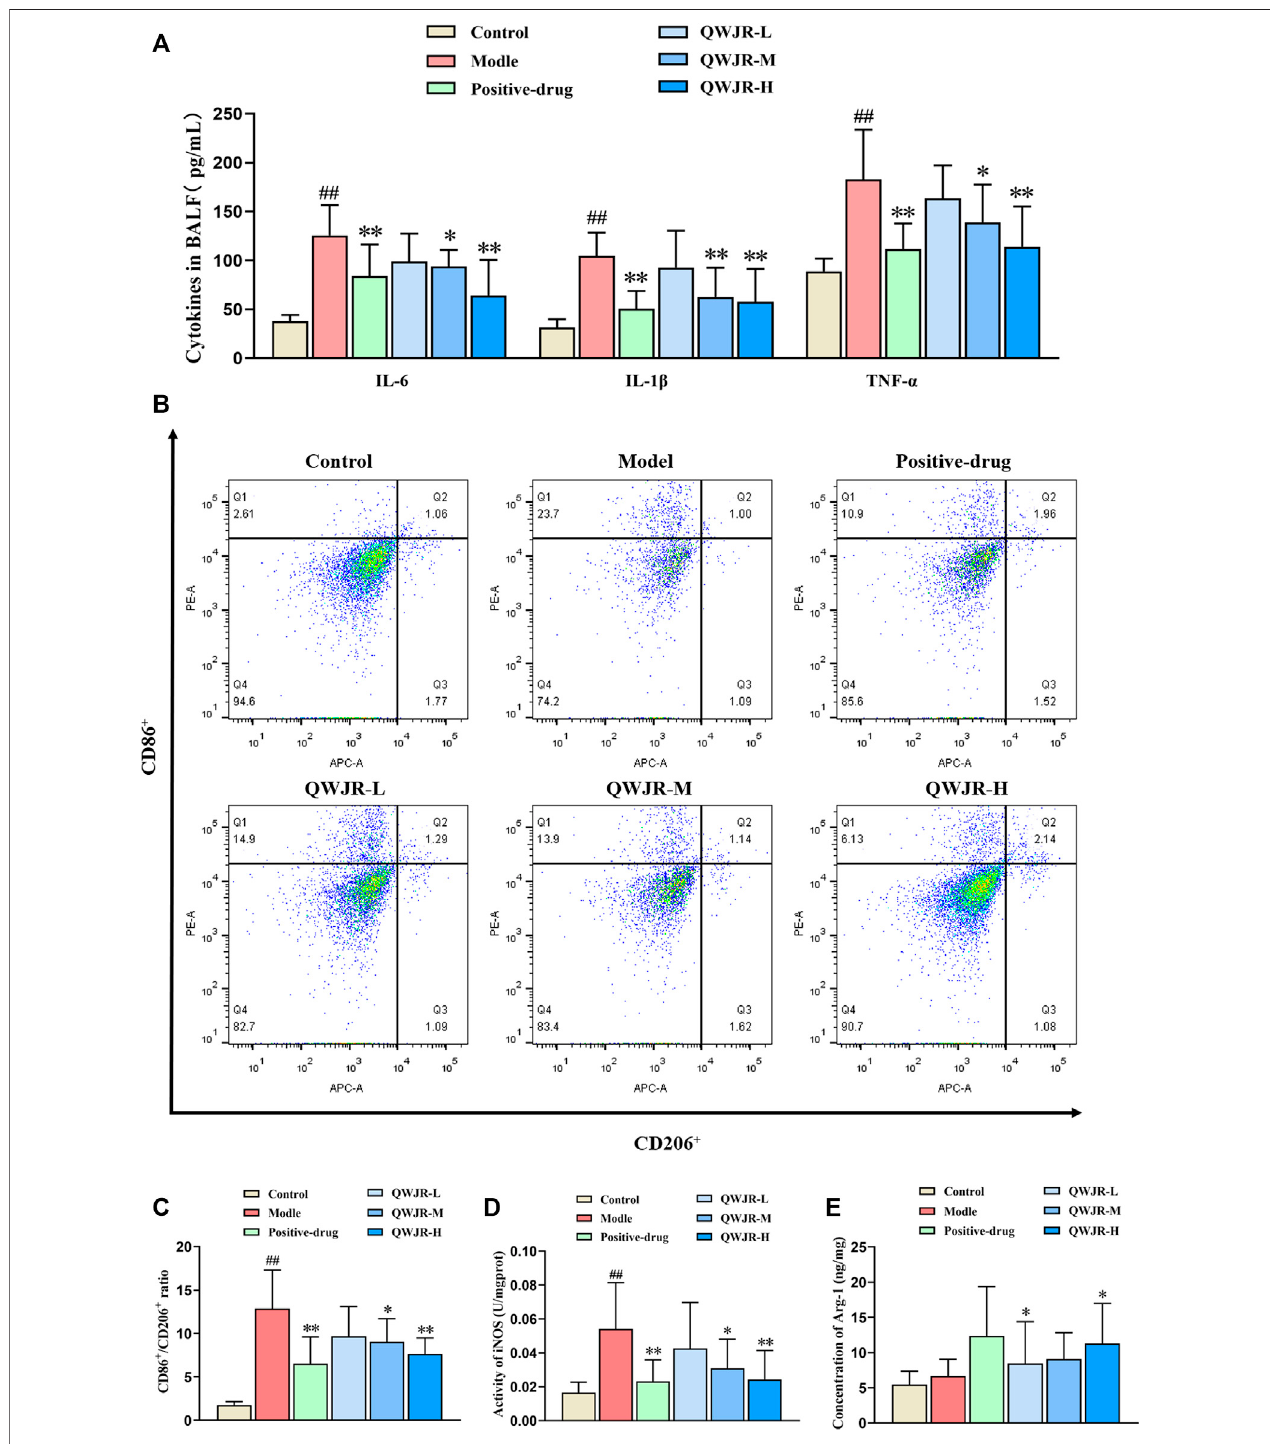
FIGURE 3 | Role of QWJR on the in fl ammatory response of poly(I:C)-induced viral pneumonia rats. (A) The levels of pro-in fl ammatory cytokines IL-6, IL-1 β and TNF- α were decreased after positive-drug and QWJR treatment. (B,C) The ratio of CD86 + /CD206 + was decreased after positive-drug and QWJR treatment. (D) The activity of iNOS was decreased after positive-drug and QWJR treatment. (E) The expression level of Arg-1 was increased after positive-drug and QWJR treatment. Control,model,positive-drug,QWJR-L,QWJR-M,andQWJR-H( n =10pergroup)groups.Dataarepresentedasthemean±SD. ## : p < 0.01ascomparedtothe control group; *: p < 0.05 as compared to the model group; **: p < 0.01 as compared to the model group.